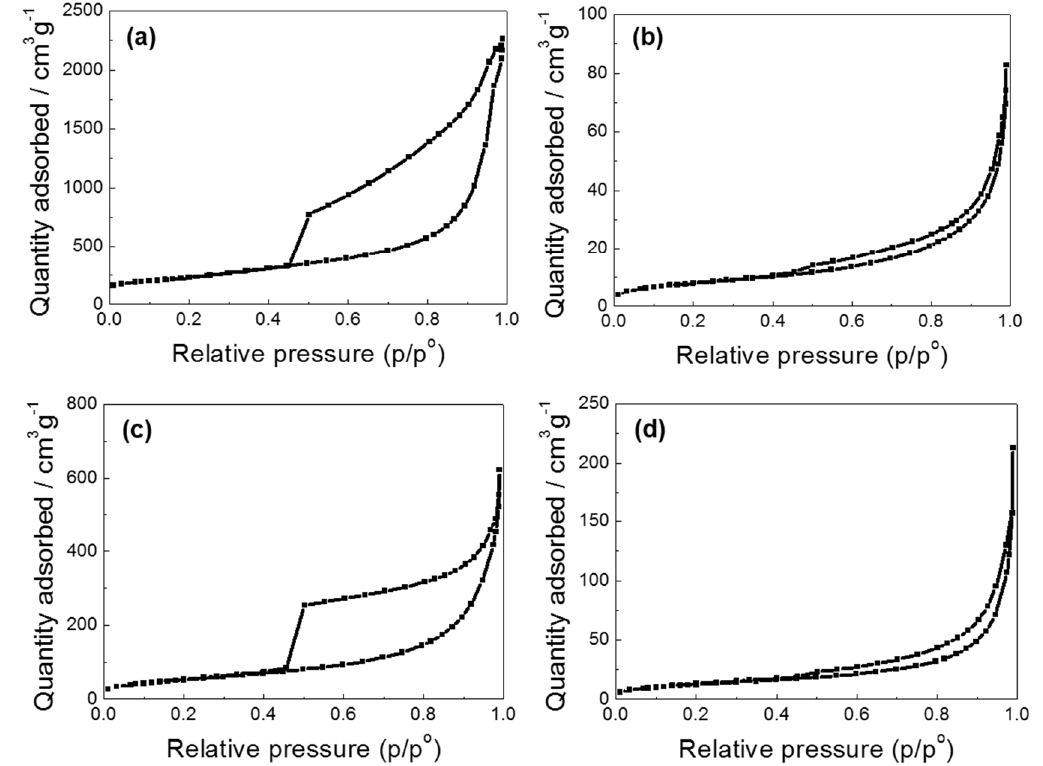
Figure 4. N 2 adsorption-desorption isotherms for ( a ) GSs; ( b ) PAQS; ( c ) PAQS/GSs(m); and ( d )